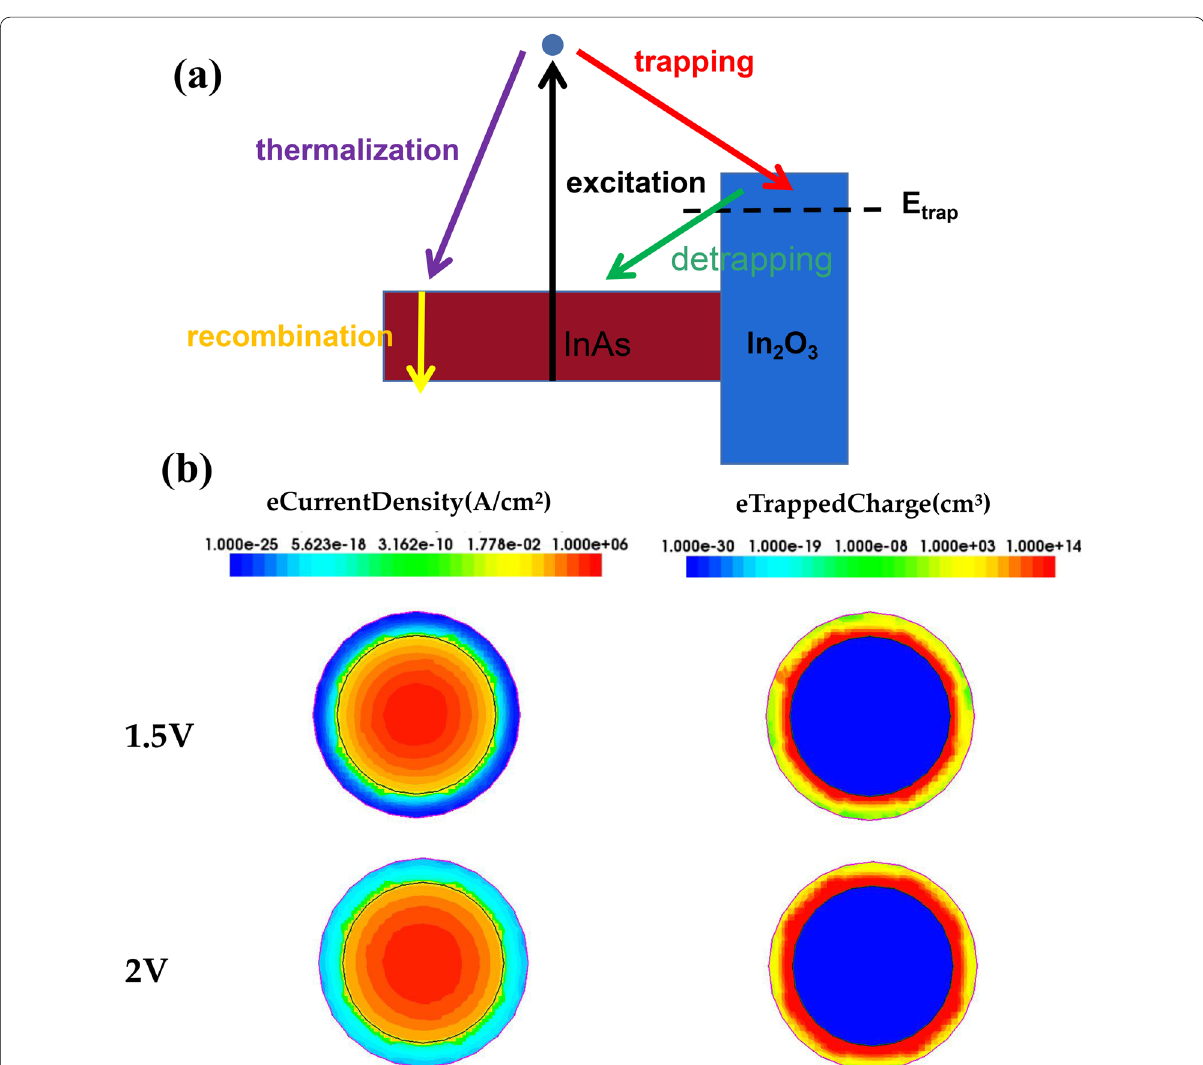
Fig. 3 a Energy band diagram of excitation, recombination, thermalization, trapping and detrapping processes, and E trap refer to trap level. b Distribution diagram of electron current density and electron trapped charge in InAs NW FETs under different gate